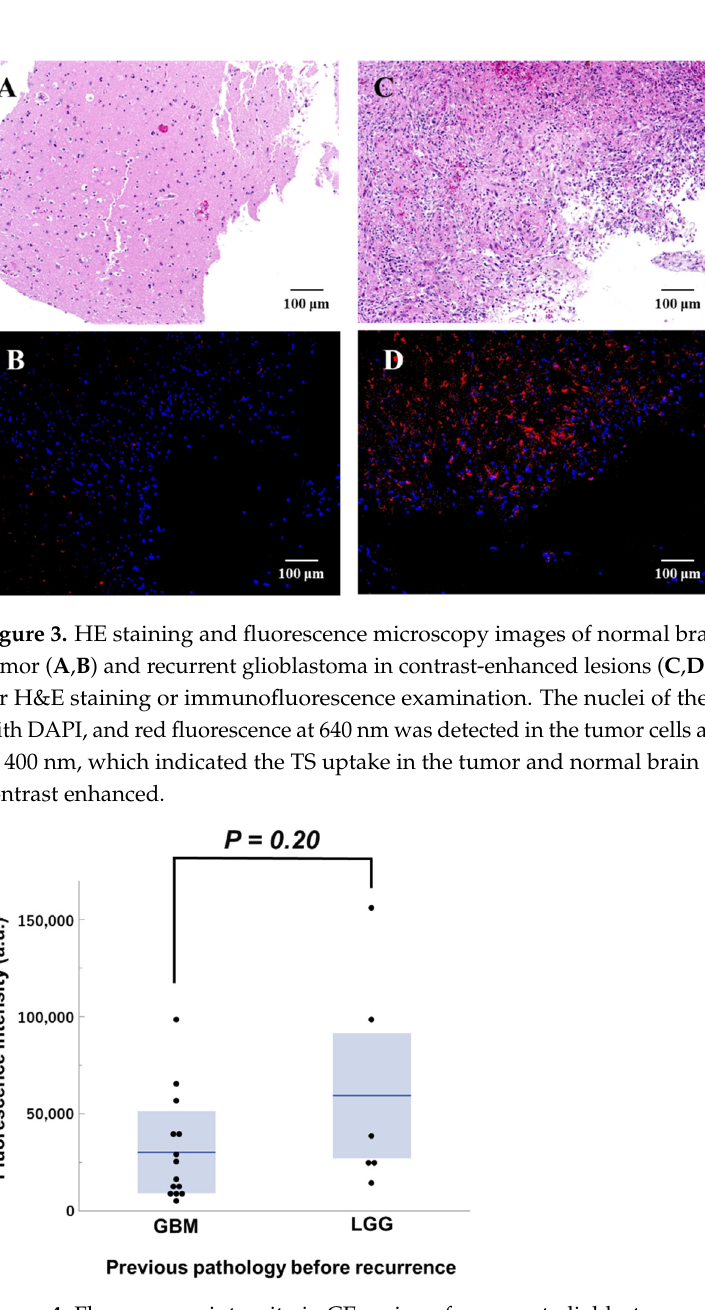
Figure 4. Fluorescence intensity in CE region of recurrent glioblastoma samples from GBM ( n = 14) and LGG ( n = 6) groups. There was no significant difference between the two groups (Mann–Whitney U test, p = 0.20). Each box represents the interquartile range, and the median was indicated by a bold line. The ends of the whiskers represented the 10th and 90th percentile.